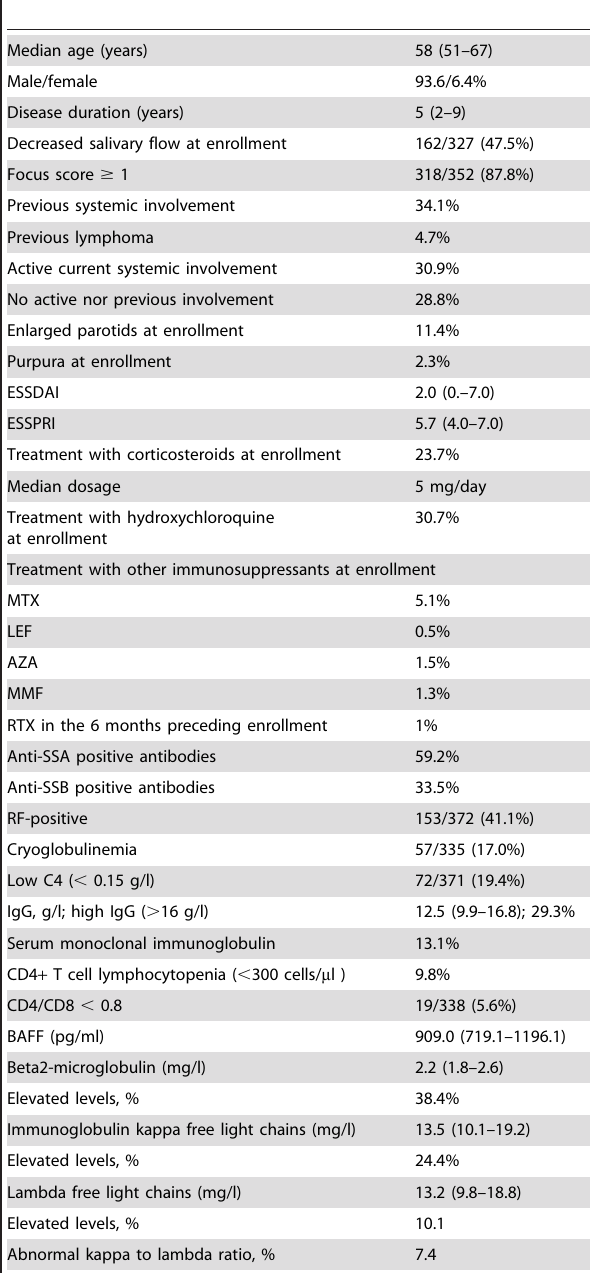
Table 1. Characteristics of patients at enrollment in the ASSESS cohort.